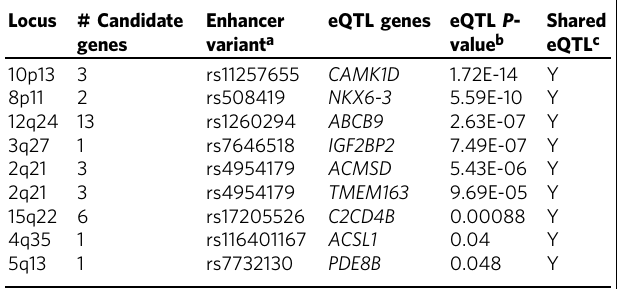
Table 1 Candidate genes with eQTLs to T2D enhancer variants Locus # Candidate